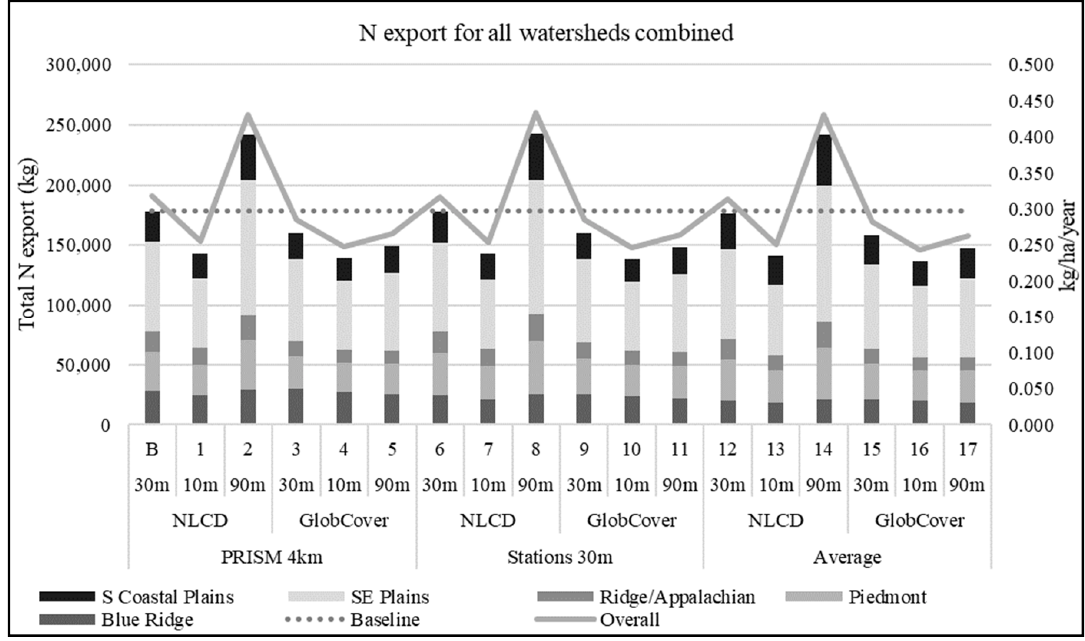
Figure 4. Total and relative nitrogen export for all scenarios aggregated from all watersheds. The bars show the total nitrogen export (kg) broken down by physiographical regions, the line provides the overall average of relative nitrogen export (kg/ha/year), and the dotted line displays the total export yielded by the Baseline (kg).